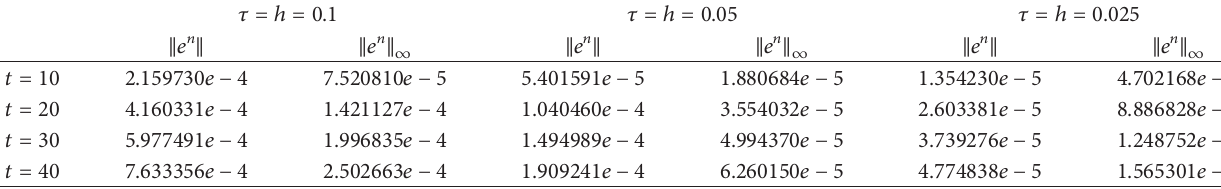
Table 1: The errors of Scheme I at various time steps with various ℎ and 𝜏 .